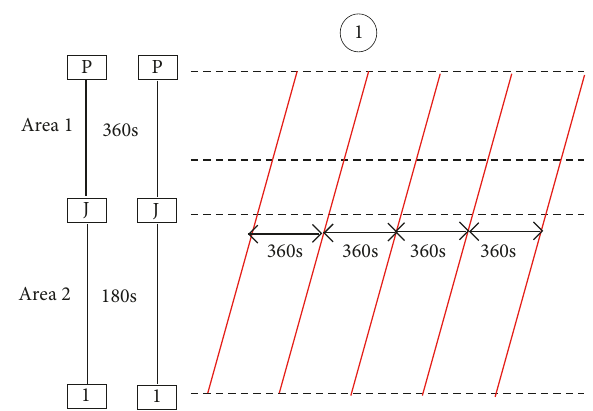
Figure 4: Only passenger demand in area 1 can be